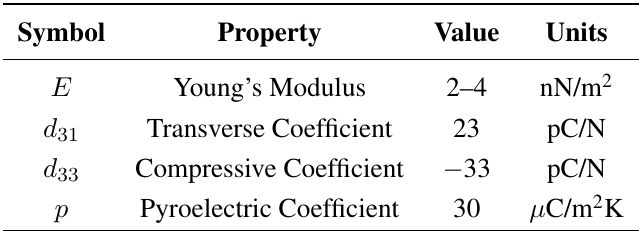
Table 1. Material properties of PVDF